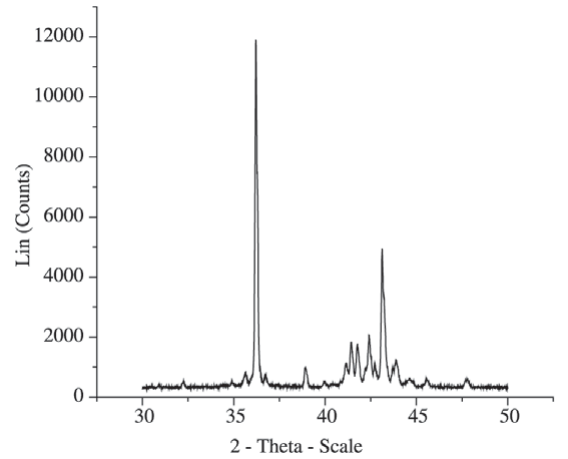
Figure 3. Typical spectrum obtained at room